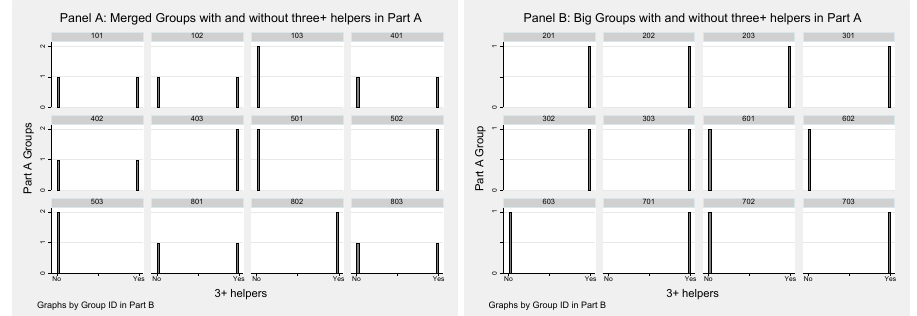
Graphs by Group ID in Part B